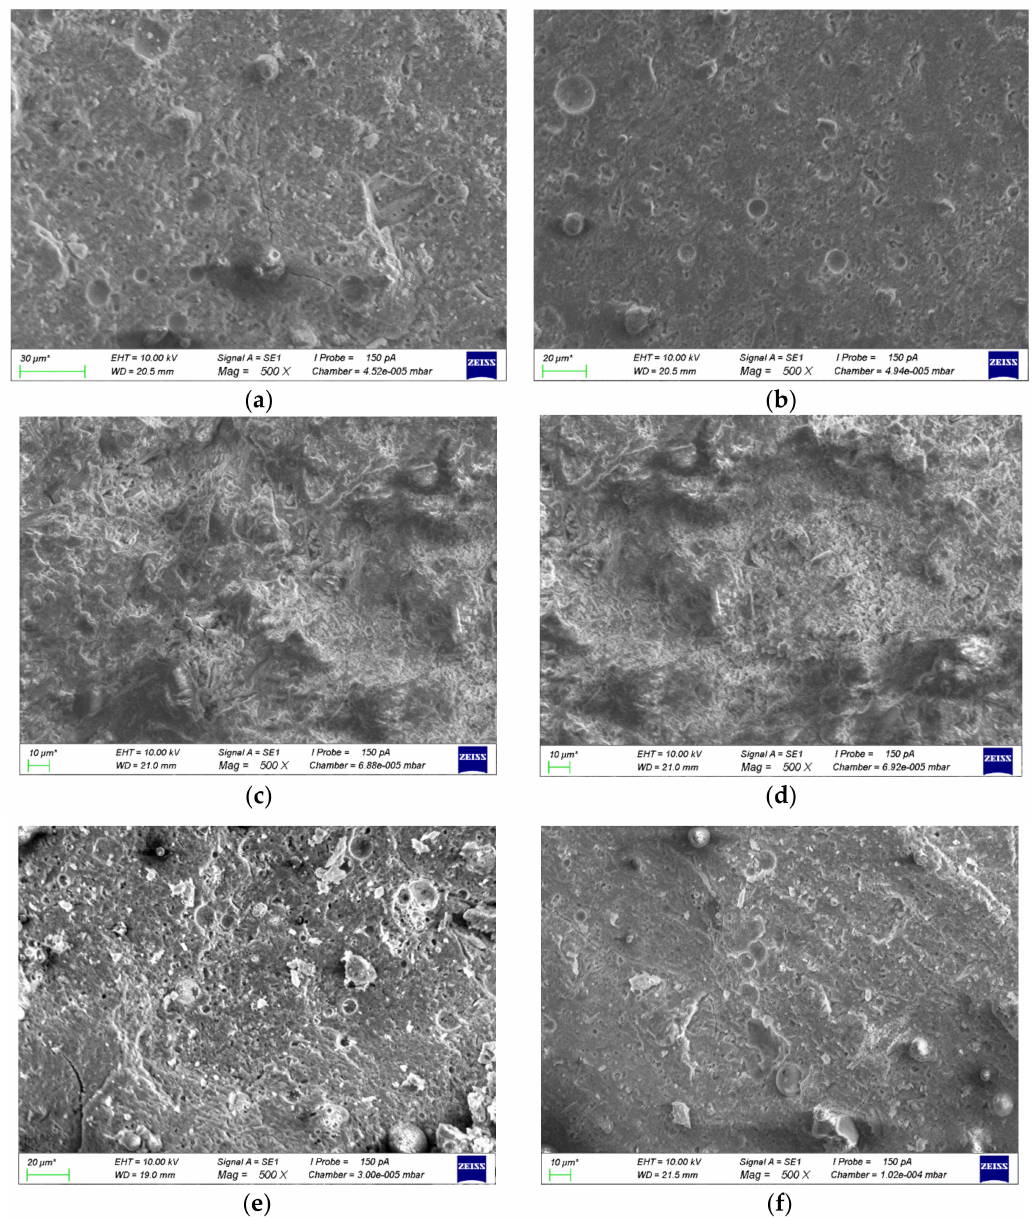
Figure 7. Micromorphology of geopolymers and cement before and after carbonization. ( a ) F2(pre- carbonization); ( b ) F2(28 d carbonation age); ( c ) PC0.65(pre-carbonization); ( d ) PC0.65(28 d carbona- tion age); ( e ) Ca10F2(pre-carbonization); ( f ) Ca10F2(28 d carbonation